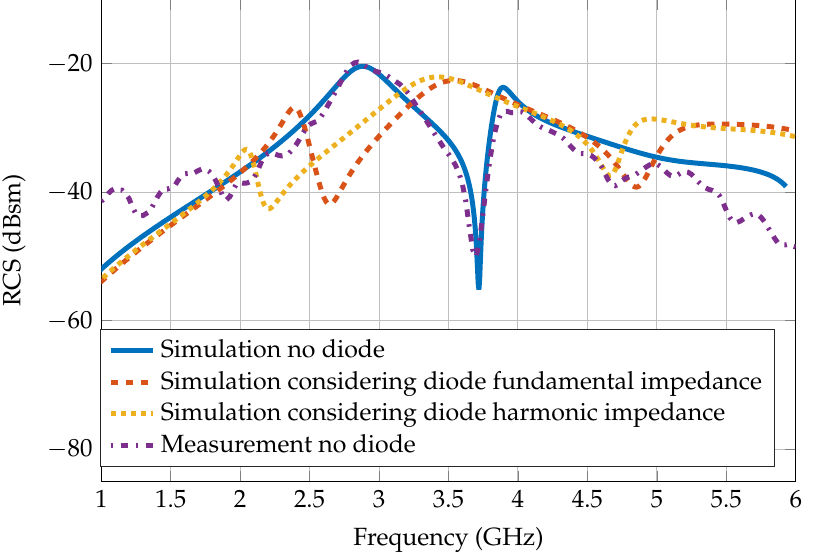
Figure 10. Transponder simulated and measured